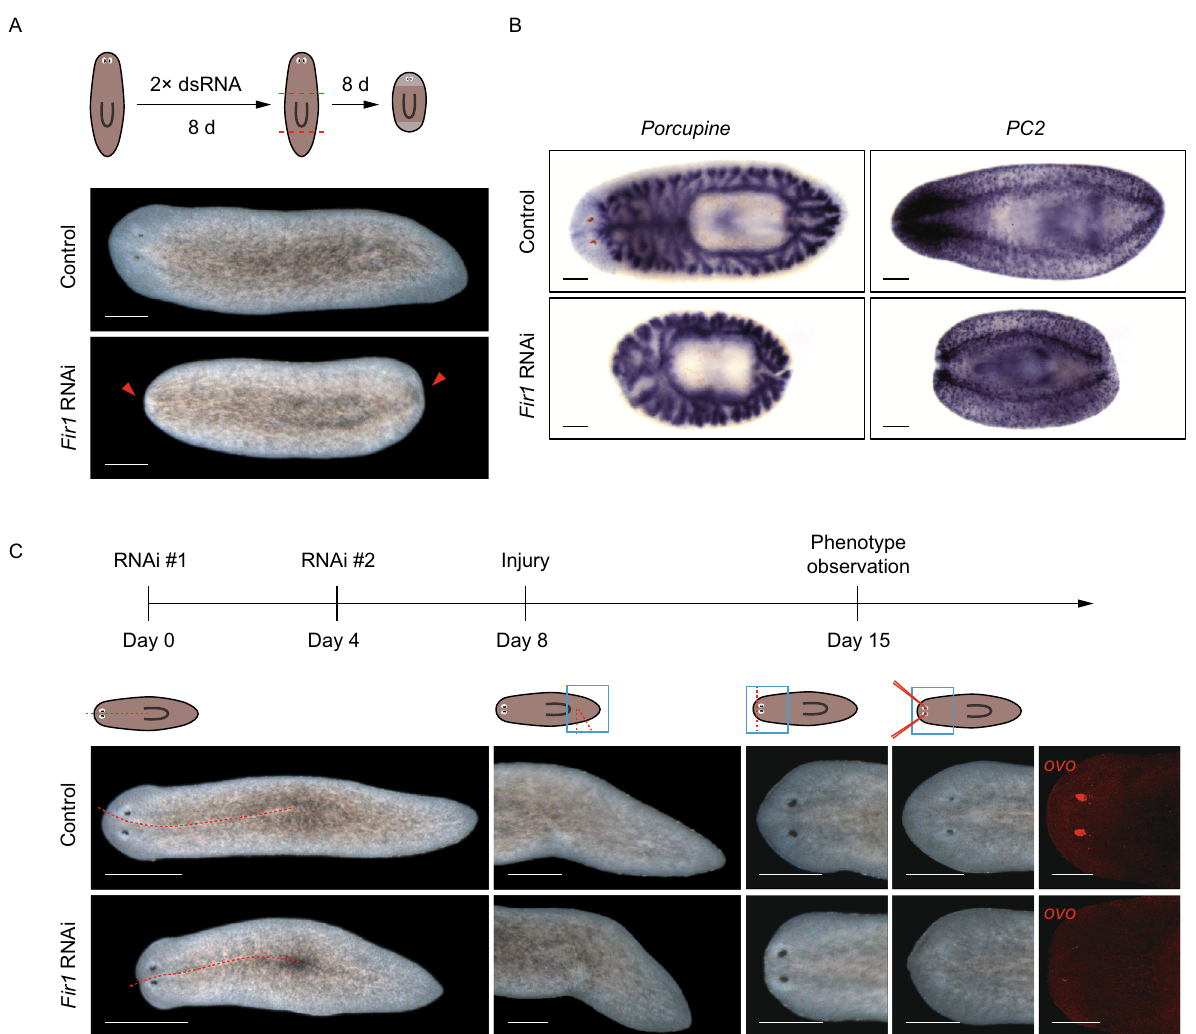
Figure 2. Fir1 is required for missing-tissue regeneration. (A) Fir1 (RNAi) animals did not form blastemas after amputation (arrowheads, n > 100). Scale bars, 500 μ m. (B) Colorimetric WISH of Fir1 (RNAi) middle pieces following 8 days regeneration for markers of porcupine (intestine) and PC2 (neurons). Scale bars, 200 μ m. (C) The regeneration phenotypes after different injury types of Fir1 (RNAi) animals. The injury included: a large incision, excision of a wedge of lateral tissue, removal of head tips and removal of eyes. ovo is an eye progenitor marker. For each surgical types, n = 6 animals. Scale bars, 500 μ